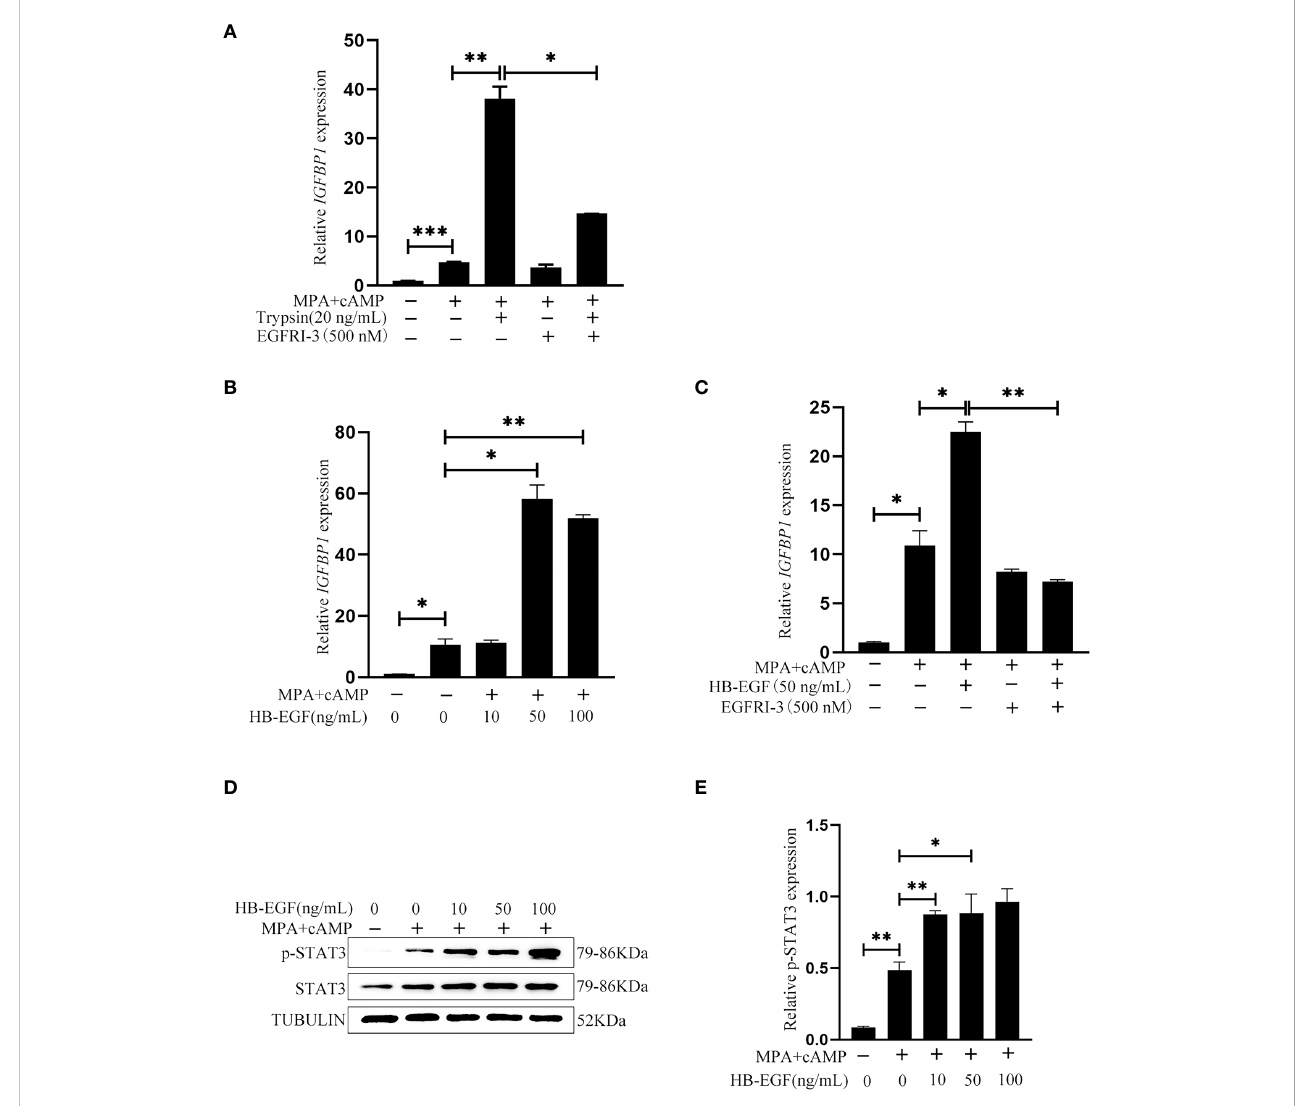
FIGURE 8 Effects of the conditioned medium from trypsin-treated Ishikawa cells and HB-EGF on human in vitro decidualization. (A) Effects of the conditioned medium from trypsin-treated Ishikawa cells on IGFBP1 mRNA level after stromal cells were cultured with the conditioned medium plus EGFRI-3 under in vitro decidualization for 24 h (B) The IGFBP1 mRNA level after human endometrial cells were treated with HB-EGF under in vitro decidualization. (C) Effects of EGFR inhibitors on IGFBP1 mRNA level when human stromal cells were treated with HB-EGF under in vitro decidualization. (D) Western blot analysis on p-STAT3 and STAT3 protein levels when human stromal cells were treated with HB-EGF under in vitro decidualization. (E) The relative protein level of p-STAT3 in Figure 8D. *, p<0.05; **,